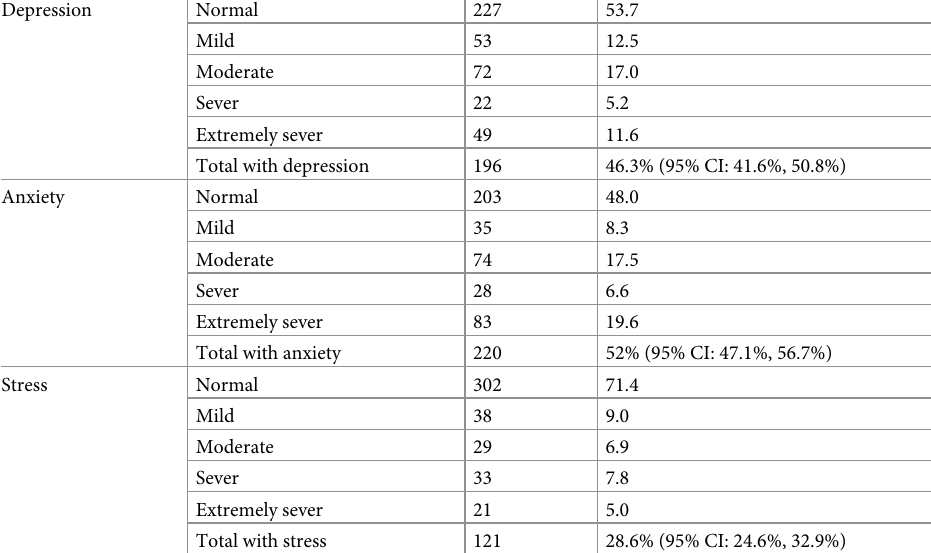
Table 2. Prevalence of depression, anxiety and stress among Ethiopian University students in Ethiopia during an early stage of COVID-19 pandemic 2020 (N = 423).